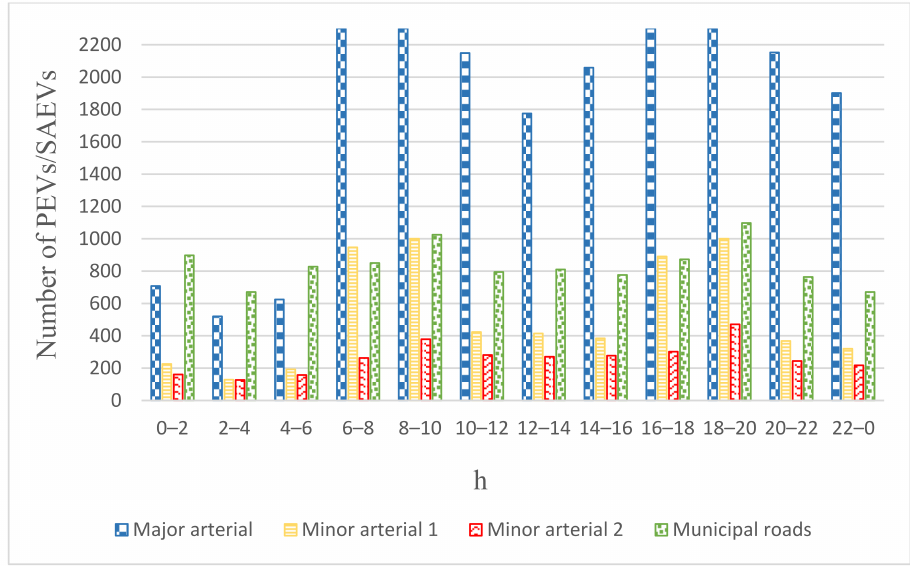
Figure 9. Traffic volumes of all road sections after enforcing real-time traffic volume